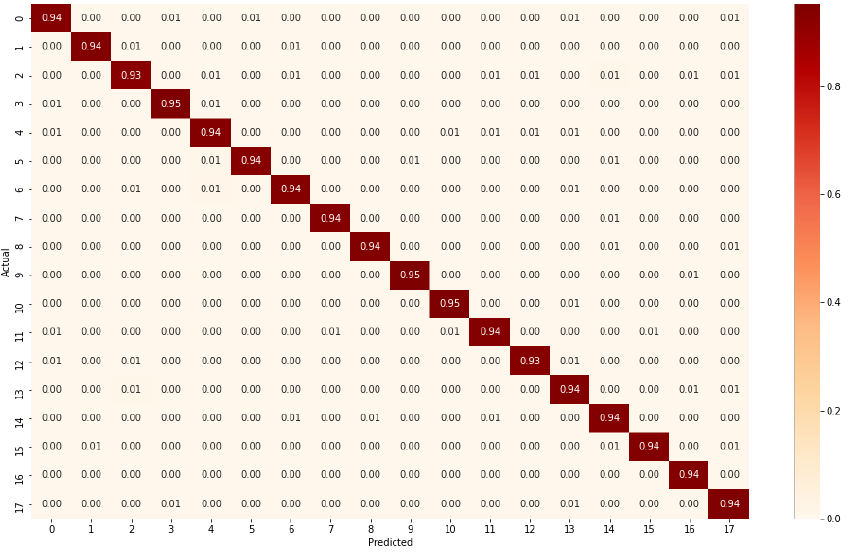
Figure 6. Confusion Matrix using MCAD Dataset. Table 4. Classification report of proposed deep learning model (Precision, Recall and F1-Score) using MCAD